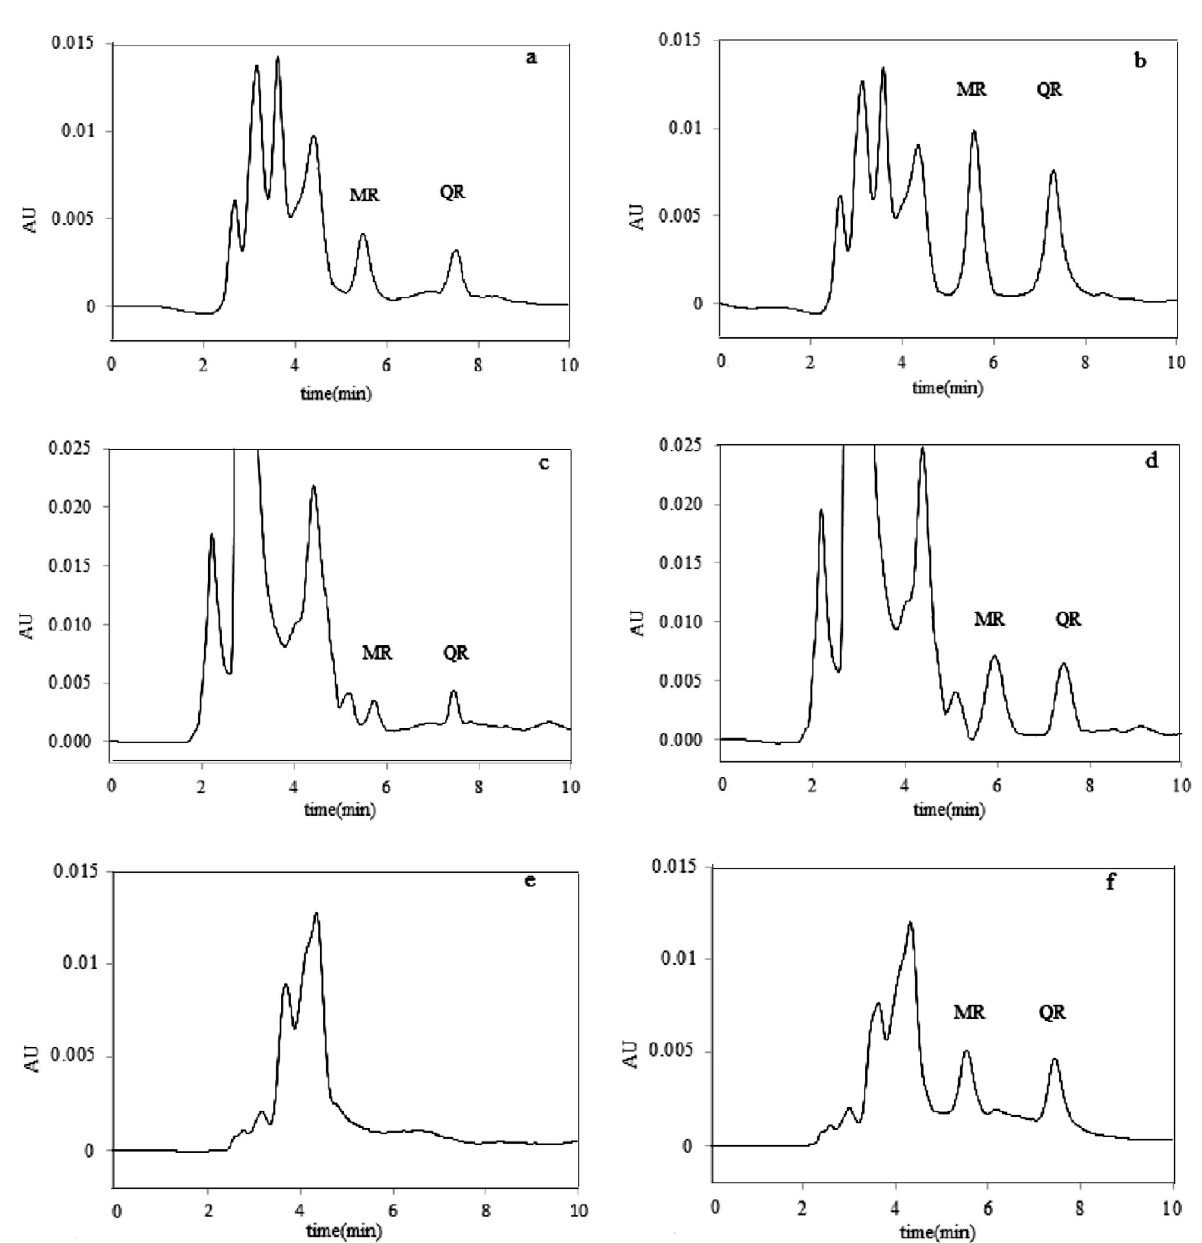
Figure 4. Typical chromatograms of (a) orange sample; (b) spiked orange sample; (c) apple sample; (d) spiked apple sample; (e) commercial apple sample ; (f) spiked commercial apple sample. HPLC conditions and experimental details were described in the text. Samples were spiked with 10 ng/ mL of MR and QR. MR = morin and QR =